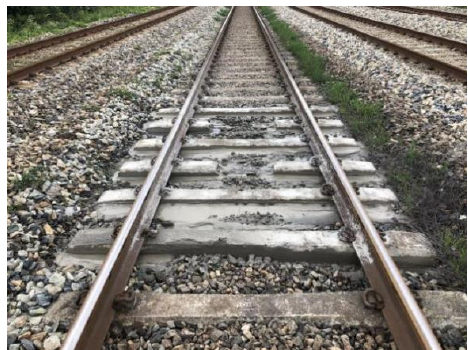
Figure 9. Hanging sleepers.